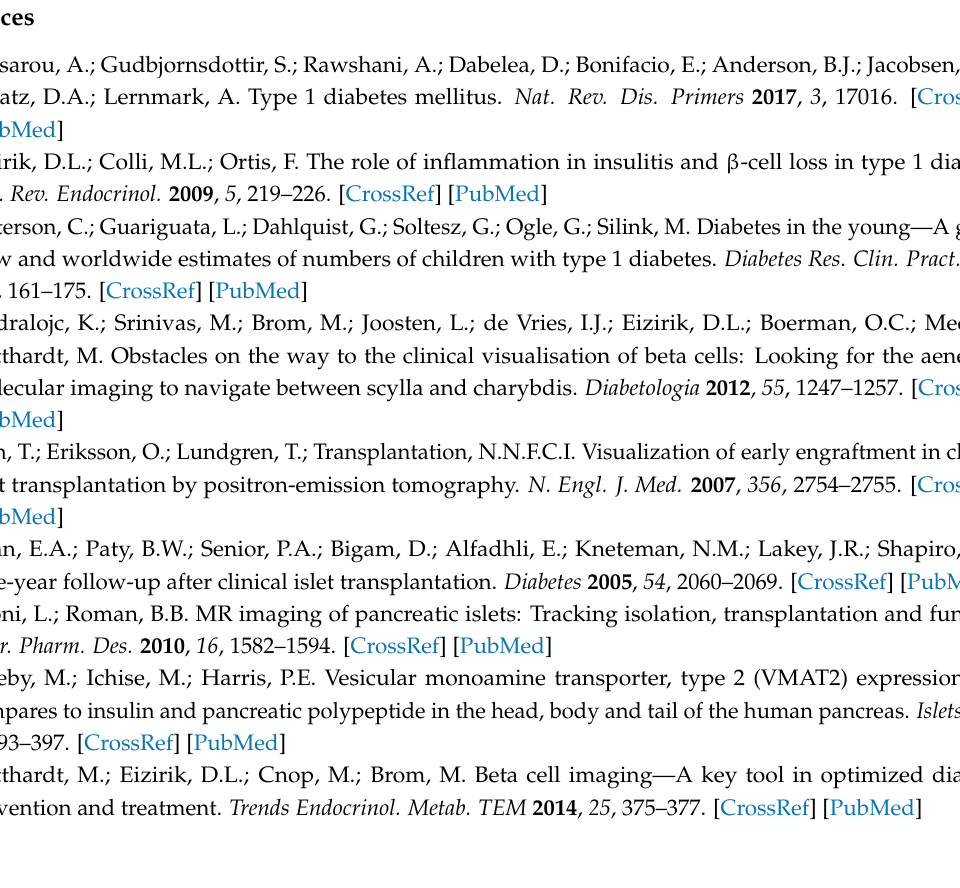
Supplementary Materials: The following are available online. Table S1: Clinical characteristics of the organ donors used for human islet isolation, Figure S1: MR imaging using Gd-DOTA-P88 and Gd-DOTA-Scramble in mice implanted with CHO-FXYD2 γ a+ or wildtype CHO cells, Figure S2: Confirmation of FXYD2 γ a expression in CHO cells transfected with the plasmid encoding FXYD2 γ a, Figure S3: Non-invasive MR imaging of EndoC- β H1 tumors in mice using Gd-DOTA-P88, Figure S4: Coupling of P88 peptide to NOTA, Figure S5: original pictures for Figure